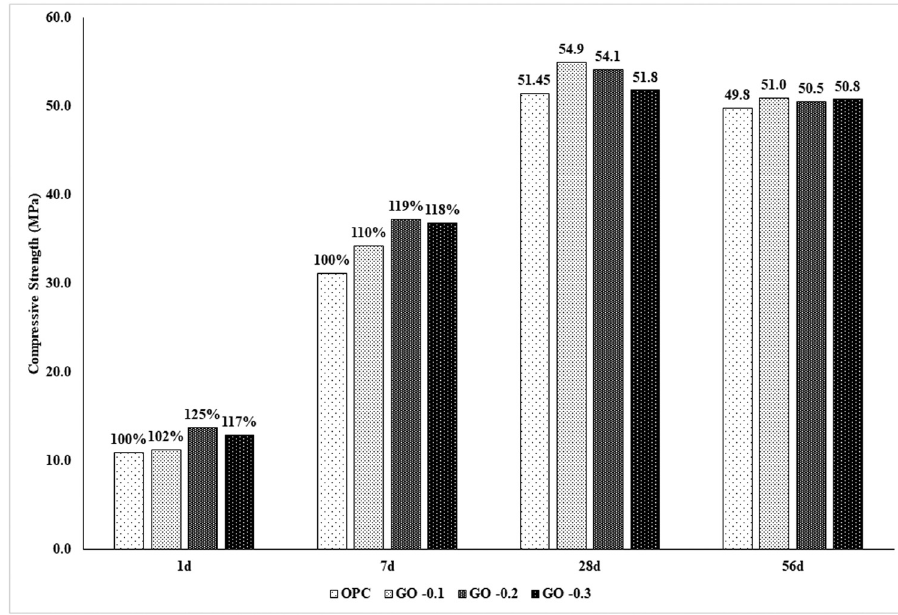
Figure 7: Compressive strengths of all